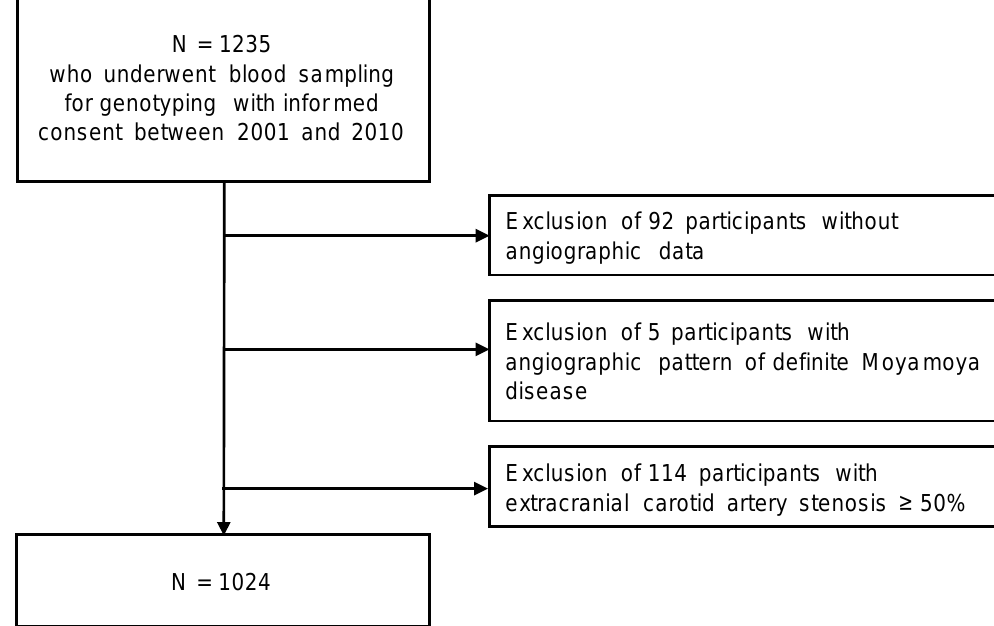
Figure 2. Flowchart of study participant inclusion and exclusion.